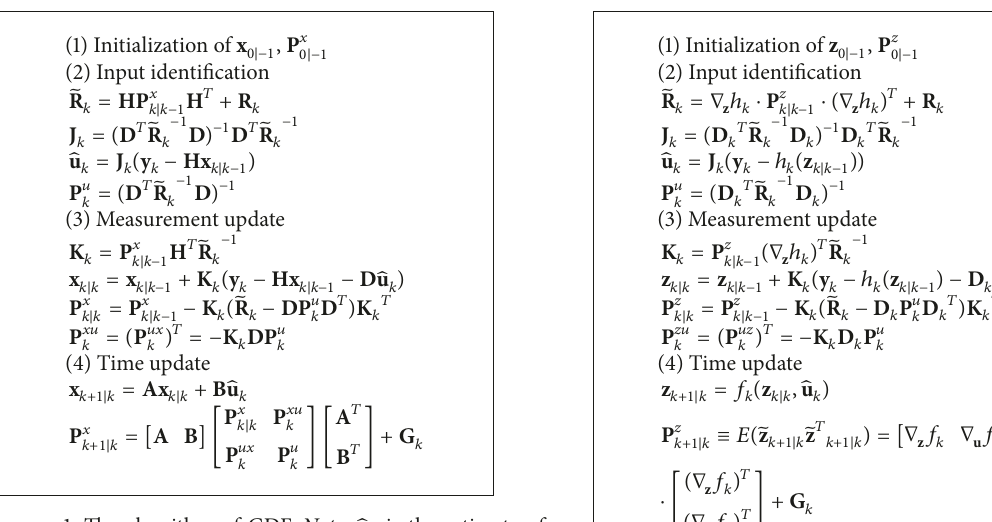
Algorithm 1: The algorithm of GDF. Note . ̂ u 𝑘 is the estimate of